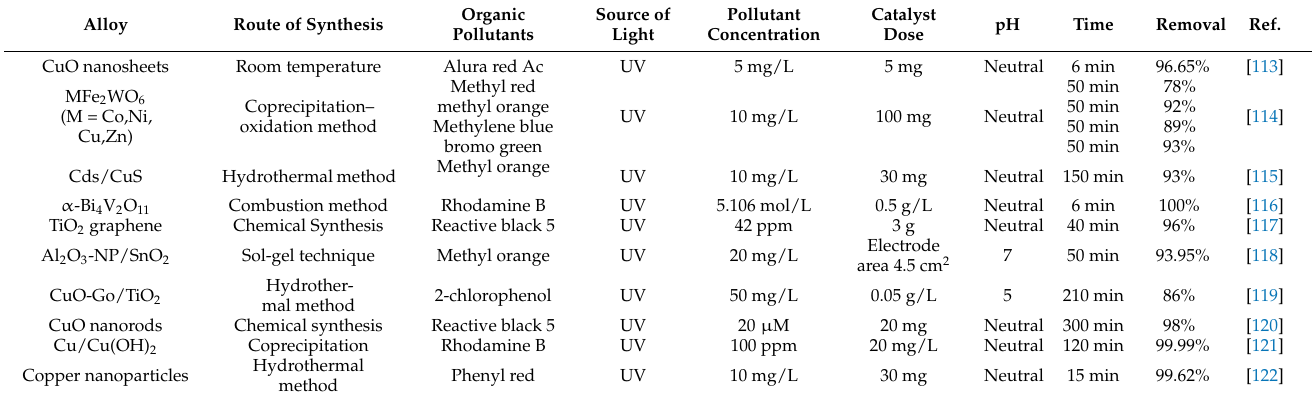
Table 3. List of nanophotocatalysts in the removal of organic pollutants.